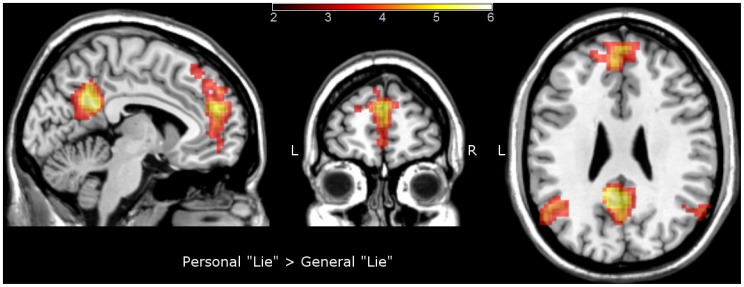
Brain activation map contrasting personal “lie” versus general “lie”.The activations are superimposed on a Colin27 template image in the MNI space. The colored bar represents t-values; L – left side; R- right side.